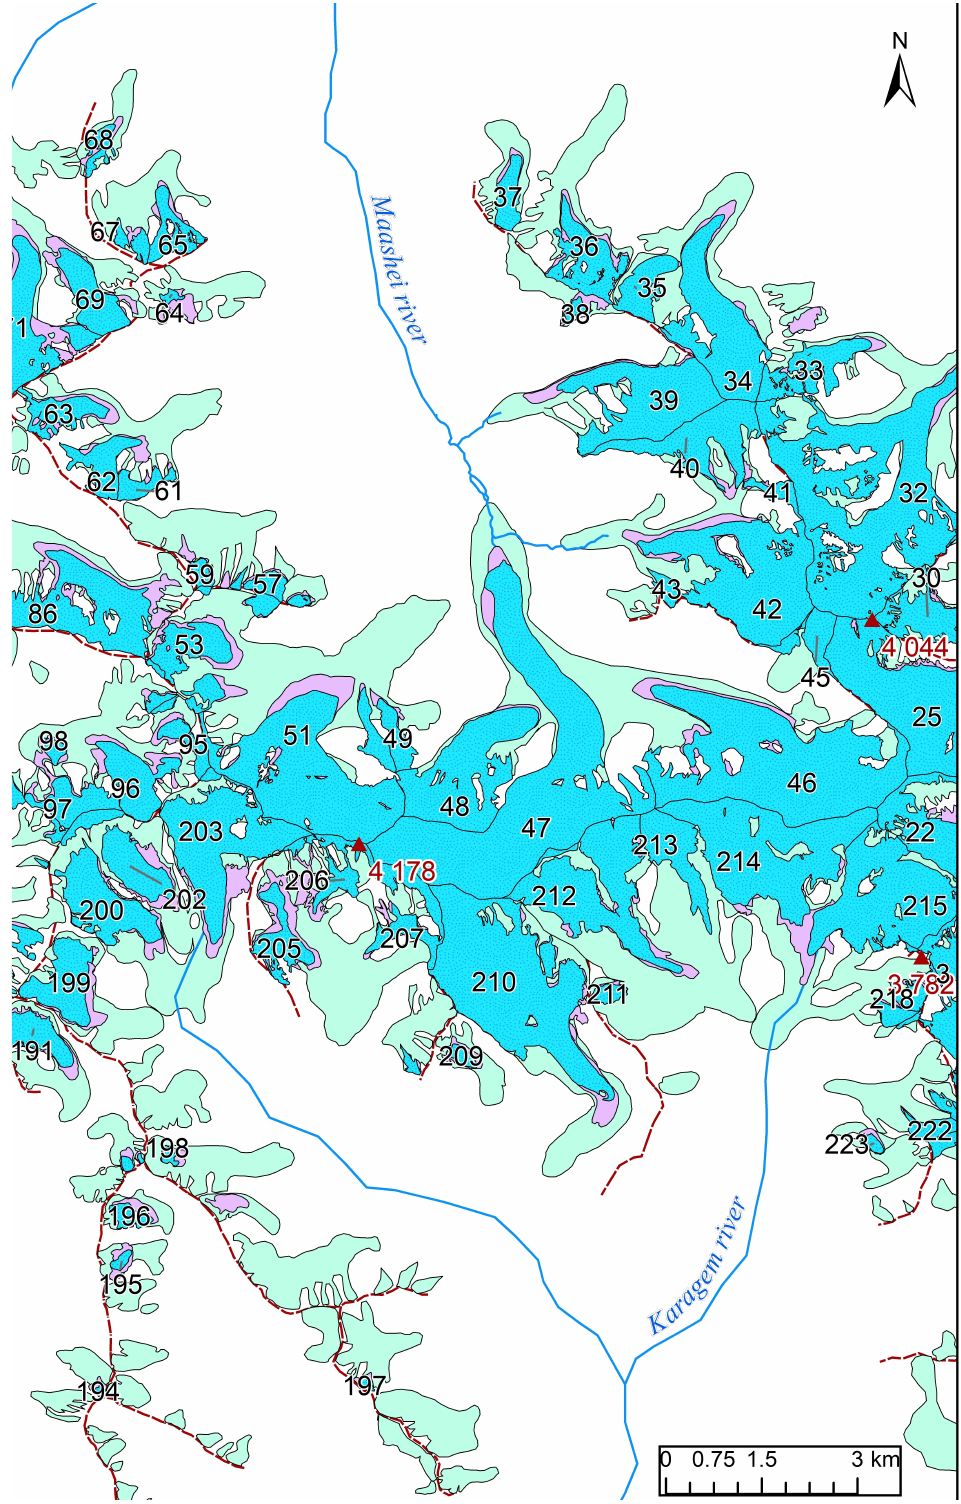
Figure 7. Reduction of the glaciers of the central part of the North-Chuya range, the basins of Maashei and Karagem (upper part) rivers, after the LIA